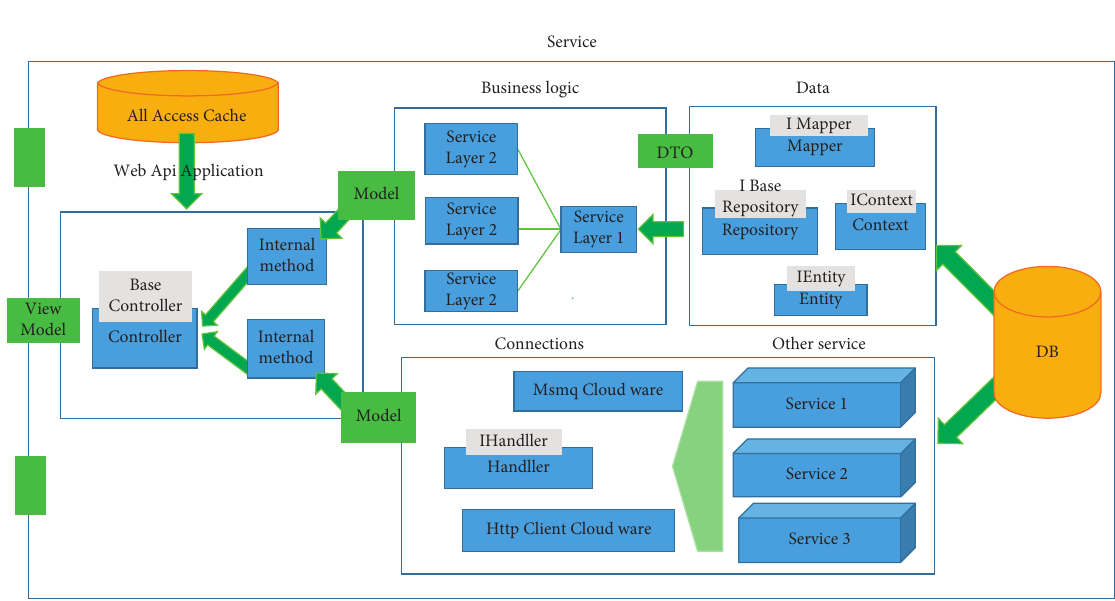
Figure 2: General architecture of dental implant